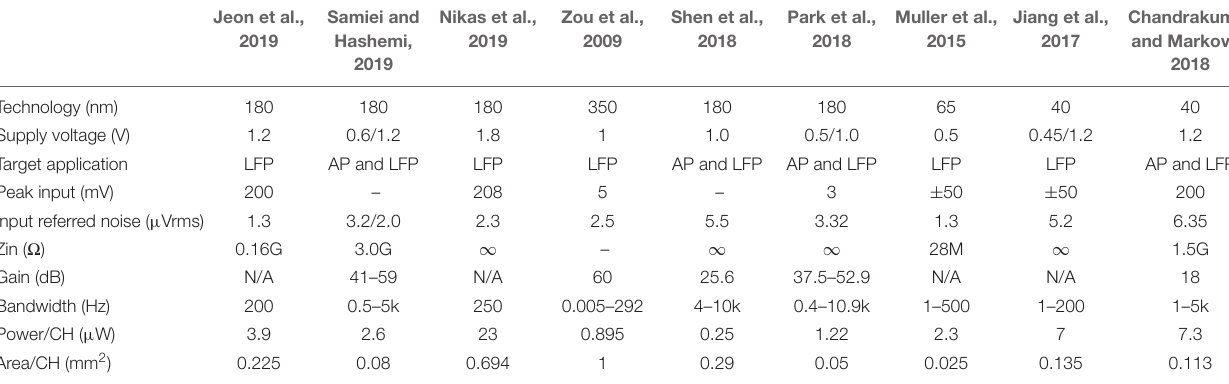
TABLE 2 | Comparison of the parameters in neural recording